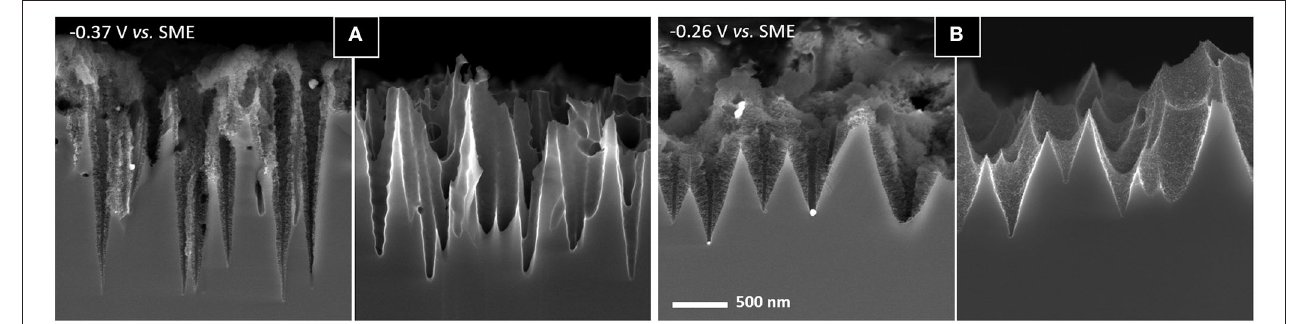
FIGURE 9 | SEM images in cross section of cone shaped pores formed in p-type silicon by MACE with silver nanoparticles in HF-H 2 O 2 with in addition an external anodic polarization ( A : − 0.37V vs. SME; B : − 0.26V vs. SME) before (left) and after (right) removing porous silicon in HF-HNO 3 . Same magnification for all images.